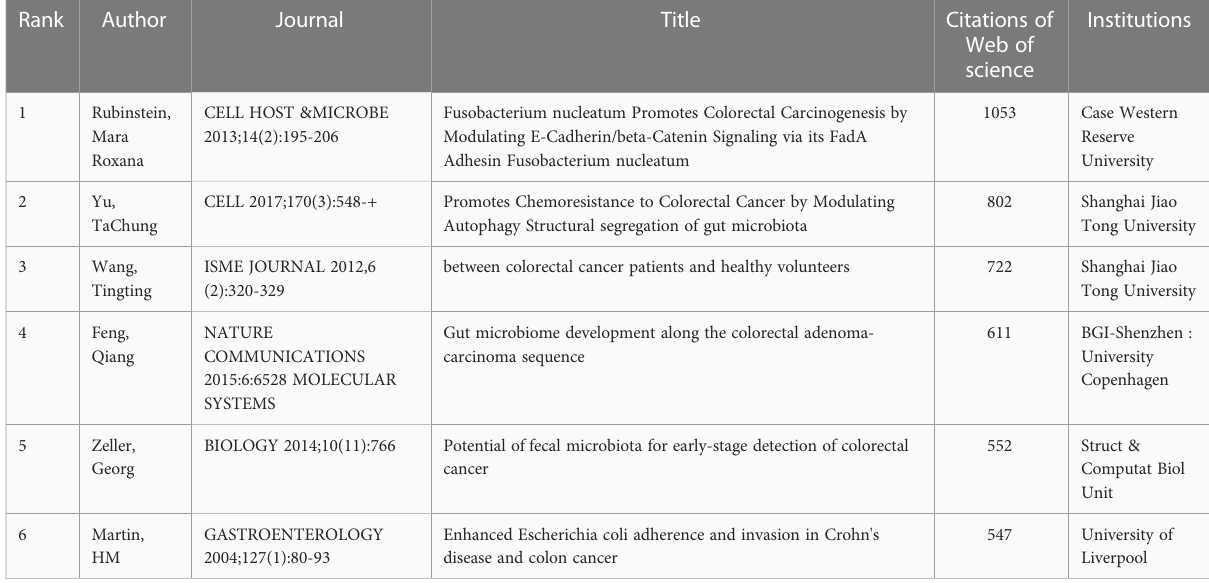
TABLE 2 The top 10 most cited articles in the fi eld of microbiota and colorectal cancer research from